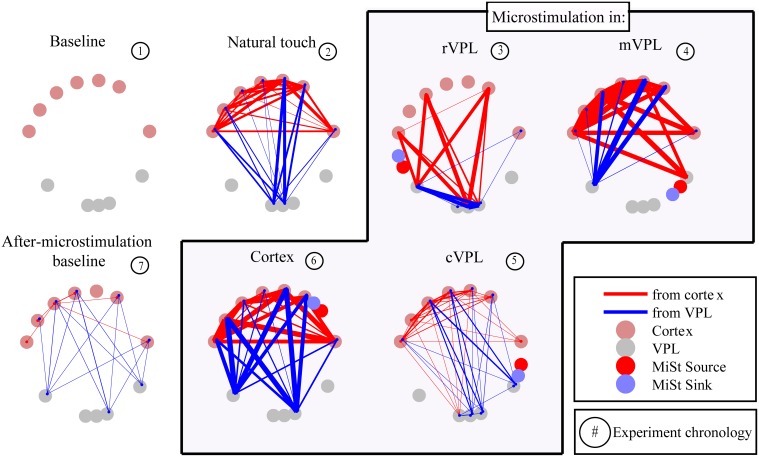
Wiring diagram of significant Granger causalities for different directions of interactions and stimulation conditions between a set of 16 cortical (top tier) and 16 VPL (bottom) recording sites in the anesthetized rat (one session's data, mean of 180 trials). Some electrodes were excluded from analysis as they were used for microstimulation or there was noise. As shown in the legend, some electrodes were used for microstimulation while others were recorded from, both sets being in the same brain region. Wires designate the network of statistically significant causal information transfer within the set of the recording sites evaluated between each pair of electrodes. Thickness of the wires is proportional to the strength of the Granger causality (FLGCy → x, see Materials and Methods, Section Causality Measurement Theory and Test and Validation). Red lines are directional influences originating in cortex; blue lines are influences originating in VPL. Panel titles indicate recording condition. Microstimulation current source and sink (2 Hz, 25 μA, 200 μs, charge-balanced bipolar, biphasic, see Materials and Methods, Section Subjects, Surgeries, and Experimental Procedures) are represented by red and blue circles respectively.